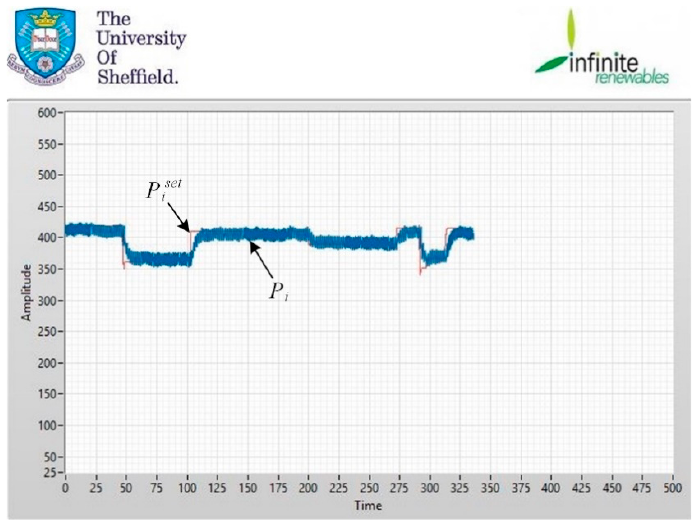
Figure 7. Desired and measured real power injected by a DER unit of the ADEPT system (real-time screenshot).